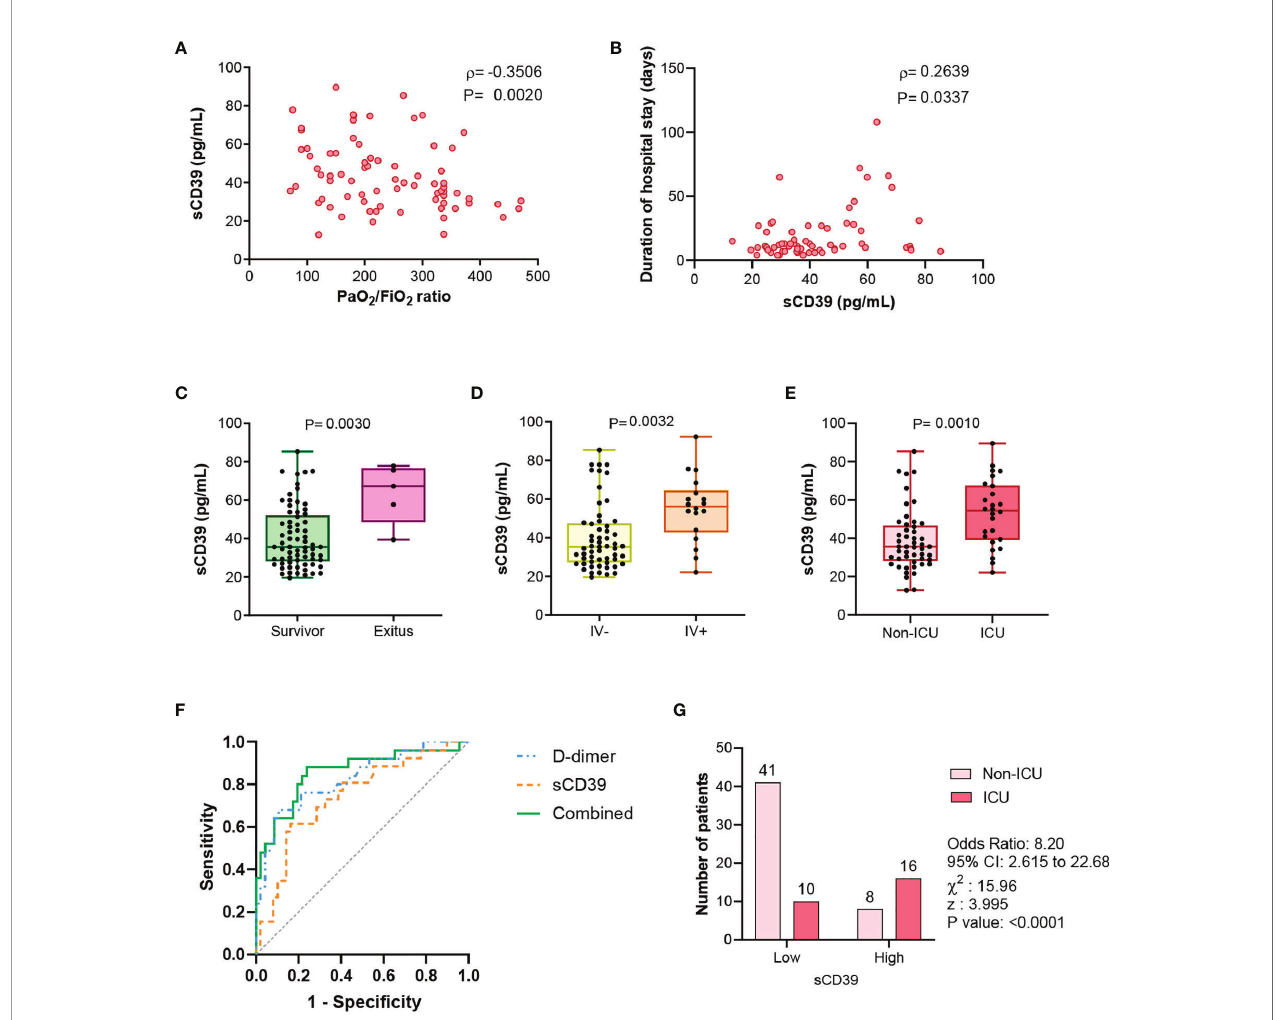
FIGURE 2 | sCD39 levels are related to COVID-19 severity clinical parameters. (A) Correlation between PaO 2 /FiO 2 ratio and sCD39 plasma concentration in COVID- 19 patients (n=75). (B) At admission sCD39 plasma levels relation with duration of hospital stay (n=65). Spearman ’ s correlation coef fi cients ( r ) and P-values (P) are shown. (C) sCD39 plasma concentration in COVID-19 survivors (n=70) and exitus (n=5). (D) sCD39 plasma levels in COVID-19 patients non requiring invasive ventilation (IV-, n=57) and patients requiring invasive ventilation (IV+, n=18). (E) Comparison of sCD39 plasma levels in COVID-19 patients not derived to ICU (non- ICU, n=49) and derived to ICU (ICU, n=26). Mean differences were analyzed using unpaired Student ’ s t-test analysis with Welch correction. (F) Receiver-operating- characteristic (ROC) curve for predictive performance value for ICU admission of sCD39 (n=71), D-dimer (n=71) and the combination of both risk factors (n=71). ROC curve was assessed by Wilson/Brown test. (G) Contingency table comparing ICU admission for patients with sCD39 plasma levels above or below the selected cut- off point (49·52 pg/mL) (n=75). Contingency table was analyzed by Chi-squared test and cut-off value was calculated by Youden ’ s